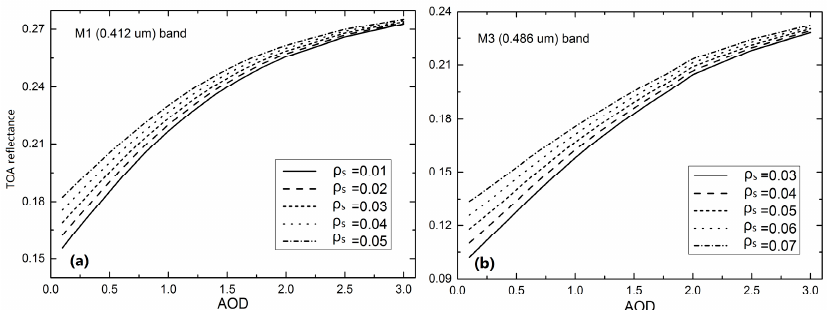
Figure 5. ρ TOA simulation for the M1 ( a ) and M3 ( b ) bands under different AOD values (ranging from 0 to 3). The different lines represent several surface reflectance values.